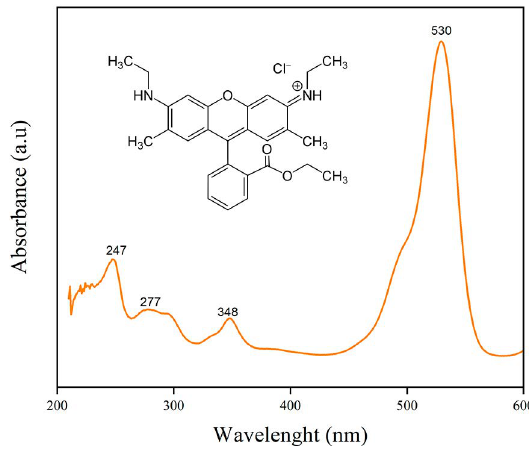
Figure 10. UV/Vis Absorption Spectrum of a 1 x 10 -3 M Rhodamine solution.